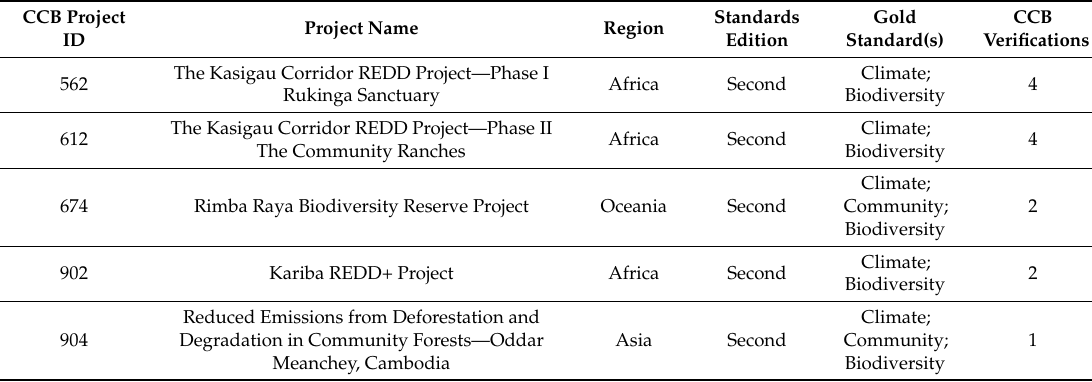
Table A1. The 25 CCB-verified REDD+ projects reviewed in this analysis; project design documents and project implementation reports are made publicly available at http://www.vcsprojectdatabase. org/#/ccb. Projects were given unique IDs during the